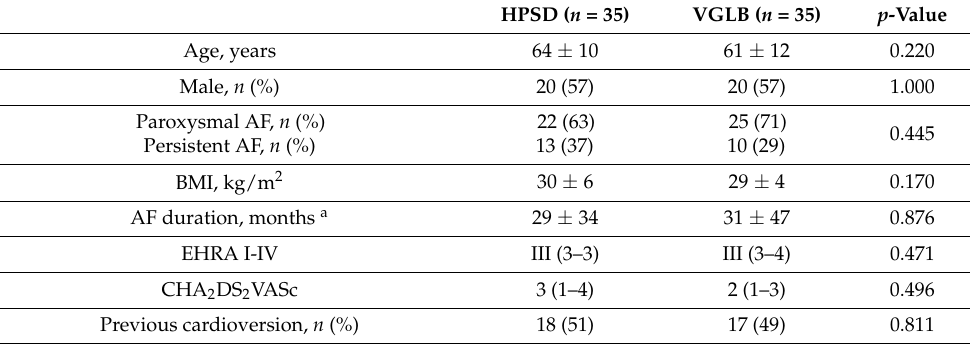
Table 1. Baseline